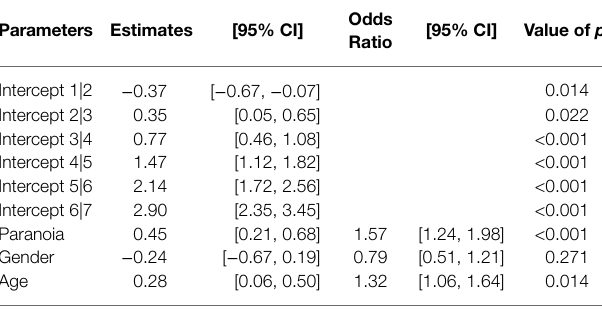
TABLE 1 | Results of an ordinal logistic regression model for predicting supposition regarding opponent’s harmful intent. Parameters Estimates